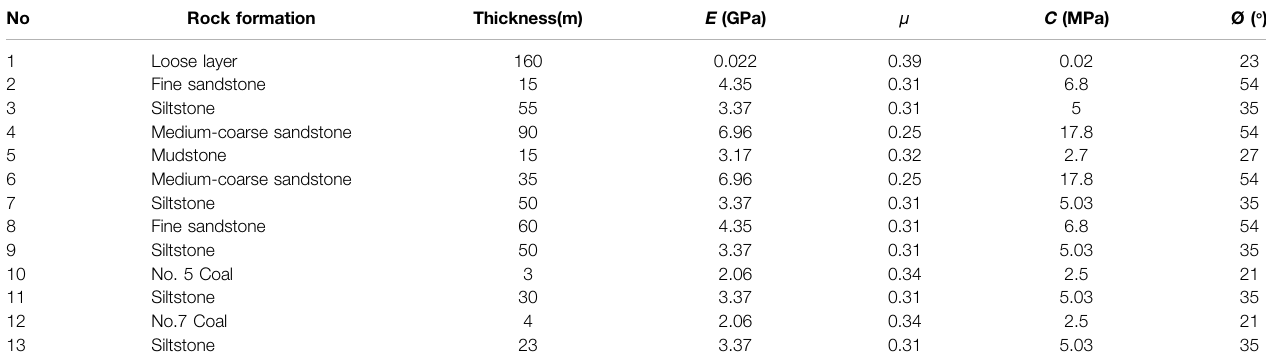
TABLE 4 | Calibrated mechanical parameters used in 3D model.